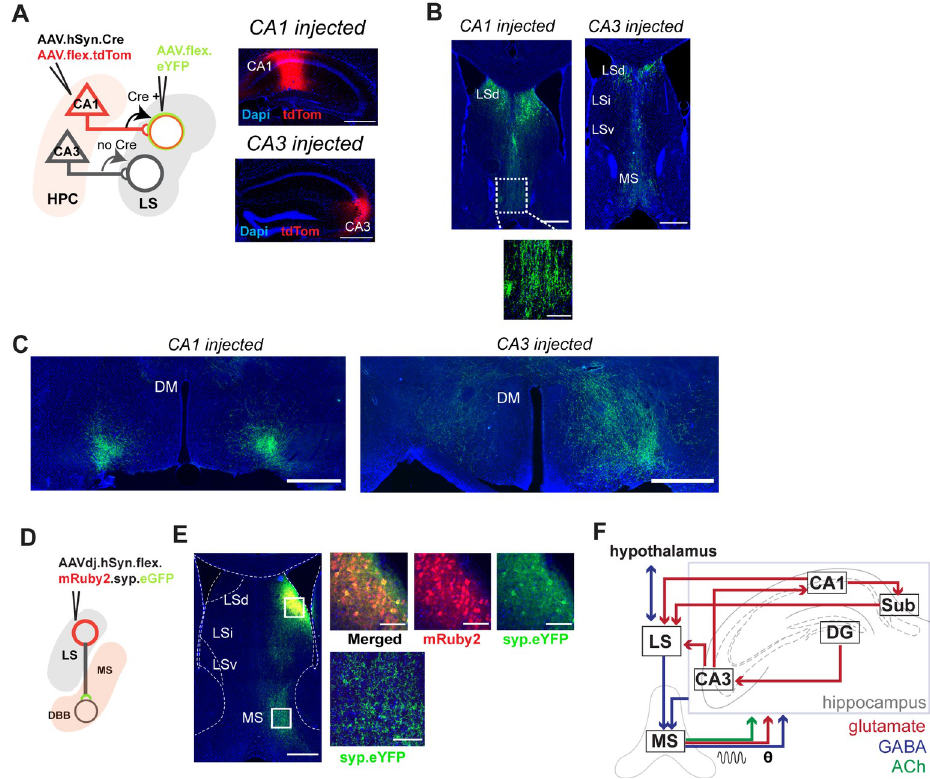
Fig 6. LS cells receiving hippocampal inputs project directly to hypothalamus and MS. (A) Diagram of dual-viral injection strategy for anterograde transsynaptic tracing. The diagram is based on dorsal CA1 targeted injection; dCA3 is also used for injections, together with coronal sections showing primary injection sites in dorsal CA1 (top) or dorsal CA3 (bottom). Red: tdTom expression; blue: DAPI, with zoomed images showing tdTom-positive cell bodies are predominantly located in the pyramidal layer (bottom). For additional images of spread of injection, see S19 Fig. (B) eYFP-positive cell bodies at the anterior dorsal LS and fibers at the level of the MS following dCA1 injection (left) and dCA3 injection (right). Inset left: eYFP-positive fibers at the level of MS. (C) eYFP-positive axons are seen bilaterally at the level of the LH following dCA1 injection (left) and dCA3 injection (right). (D) Injection strategy for Cre- dependent AAV. Synaptag mediated tracing in the LS. (E) Coronal section of dorsal LS, with synaptophysin-bound eYFP at the MS. Top right: zoomed images showing transduction at the injection site. Bottom right: eYFP-positive fibers. (F) Schematic with proposed connections of the LS within the hippocampal network. Scale bars: B, left and right: 800 μ m. C, left and right: 500 μ m. The underlying data can be found in S1 Data. DBB, diagonal band of Broca; DG, dentate gyrus; DM, dorsomedial hypothalamic nucleus; HPC, hippocampus; LH, lateral hypothalamus; LS, lateral septum; LSd, dorsal lateral septum; LSi, intermediate lateral septum; LSv, ventral lateral septum; MS, medial septum. We observed that dCA1-LS preferentially targets the LH, and dCA3-LS targets the hypothala- mus more broadly as well as the nuclei of the medial zone. Whether the GABAergic cells of the LS form functional synapses at the level of the MS/diagonal band complex is debated [5,26,66– 68]. Thus, in order to determine whether the projections observed at the level of the MS with both our anterograde tracing approaches constituted passing fibers or synaptic connections, we used an AAV-Flex-Synaptag [69], a Cre-dependent viral construct to express mRuby in the cytosol and eGFP bound to synaptophysin, a protein primarily expressed in the presynaptic endings of cells participating in synaptic transmission (Fig 6D). For this, we used a CaMKII α - Cre mouse line, expressing Cre only in CAMKII-positive cells, a marker that is abundant in the GABAergic cells of the LS but absent in the MS, thereby preventing any unspecific labeling. After expressing AAV-Flex-Synaptag in the intermediate LS, we observed significant synapto- physin-bound projections in the MS (Fig 6E), confirming the existence of a synaptic interface